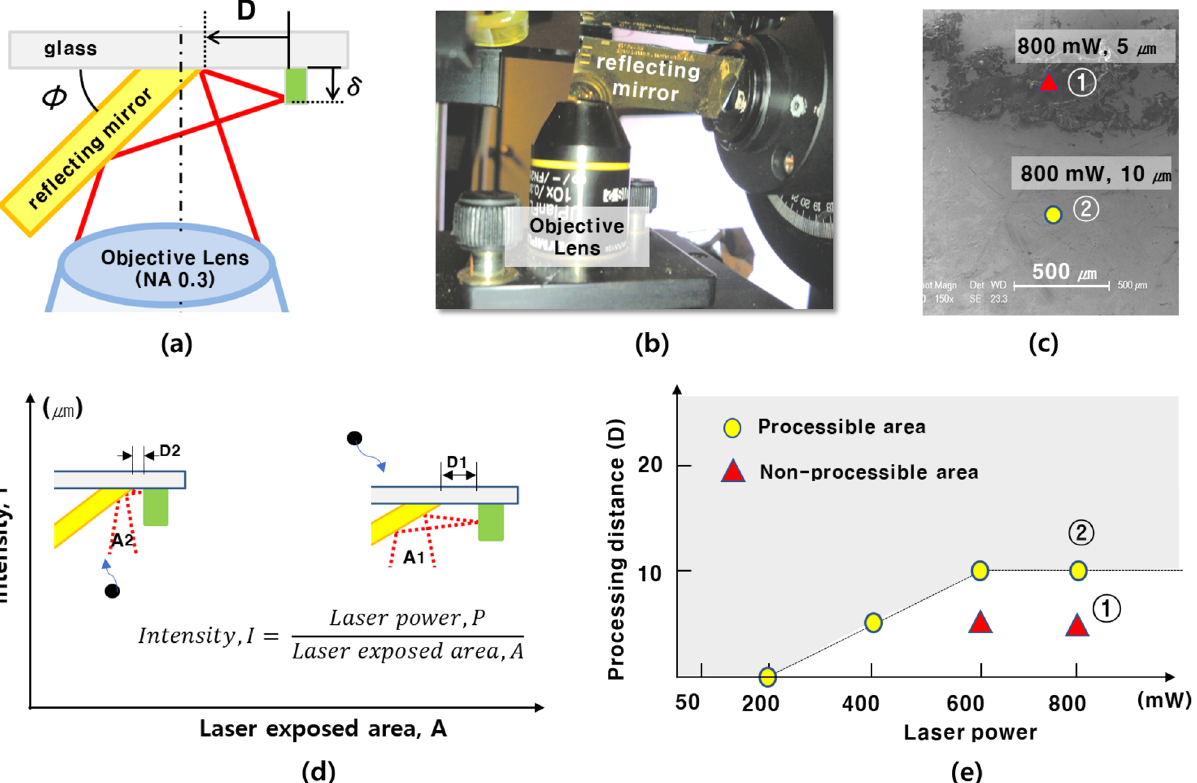
Figure. 4. ( a ) Schematic illustration of laser reflecting in multi-directional ablation system. ( b ) Photo of the multi-directional ablation system. ( c ) Schematic graph of laser intensity according to laser exposed area. As the laser intensity (I) increases, the processing distance (D) is shortened. ( c ) SEM image showing the experimental results of the reflecting mirror surface damage test by various exposed laser powers with 800 mW at the processing distances of 5 μm and 10 μm. The red- and yellow-colored symbols indicate the point of EDAX analysis. ( d ) Fabrication distance between the reflecting mirror and structure considering the damage. ( e ) Processable area for multi-directional ablation process according to the laser power and process to the EDAX data. This result indicates that the gold-coated surface layer was damaged by the laser exposure. In the processable area ( ② ), the gold component was dominant. This indicates that the gold-coated surface layer was not damaged by the laser. Figure 4e shows the processable area according to the laser power and process distance. The yellow-dot indicated the processive point and the reflecting mirror is not damaged by the laser. However, the red-dot indicated the non-processive point and the reflecting mirror was damaged. As the reflecting mirror closely approached the microstructure, the ablation process-limited area was reduced. Figure 5a and b show that the ablation process limited the height of the microstructure when the laser was exposed to the lateral side of the microstructure and scanned using the galvano scanner. As shown in Fig. 5a, when the process distance is 30 μm, the height of the process is 5 μm. However, when the process distance was 100 μm from the target microstructure, the process-limited height increased to 22 μm. Because the process distance is far from the microstructure, the laser focus cannot reach the bottom of the microstructure, and the process-limited height is increased. When the processing distance is shortened, the process can be performed by minimizing the process-limited height. The process-limited height can be predicted using these experimental results (Fig. 5c). Experimental results with multi‑directional ablation process. For multi-directional ablation, the NA 0.3 objective lens was used. According to previous research, the optical shape of the focused laser is a pro- late spheroidal shape 35 . A smaller NA resulted in an elongated focus shape. Moreover, the laser intensity along the travel direction is greater than that along the lateral direction 36 . The conventional laser ablation process is unsuitable for lateral surface patterning. For precise patterning on the lateral surface, the focal plane must be rotated using a multi-directional ablation system. As shown in Fig. 6a, when the multibeam structure needs to be drilled into a single-beam structure, the laser is reflected by the mirror, and the processing plane is rotated. This rotated focus leads to a precise hole pattern in a single-beam structure. A three-beam structure was fabri- cated using the TPS process. The height and width of each beam were 5 and 1 μm, respectively. To create a hole in the upper beam structure, the direction of the focal plane was precisely controlled using a reflecting mirror. To create a precise hole pattern, the laser power was 100 mW, which is the smallest laser power for the ablation process. As shown in Fig. 6b, a 500 nm single-hole pattern was formed in the upper beam structure. Figure 6c